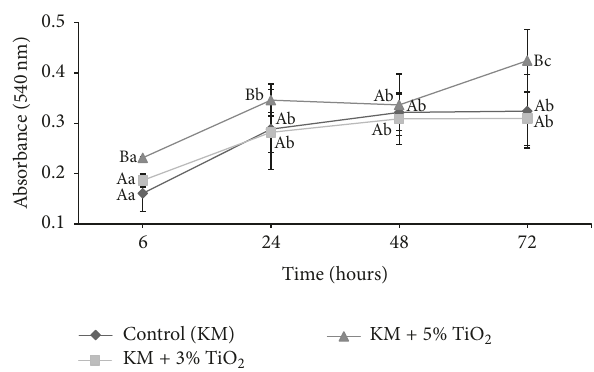
Figure 2: Cell viability of the experimental groups at 6, 24, 48, and 72 h. Different uppercase and lowercase letters represent intergroup and intragroup differences, respectively, by two-way ANOVA